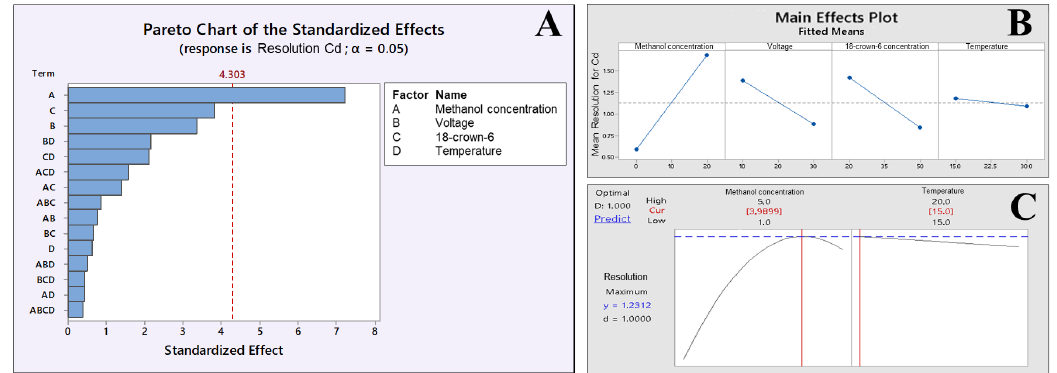
Figure 3. ( A ) Pareto, ( B ) main effects, and ( C ) desirability (methanol concentration and temperature). Graph obtained through DOE by Minitab ® software to optimize the separation by CE for Cd 2+ and Pb 2+ determination in Passifora incarnata tea. Table 2. Levels used for the implementation of DOE using two factors.